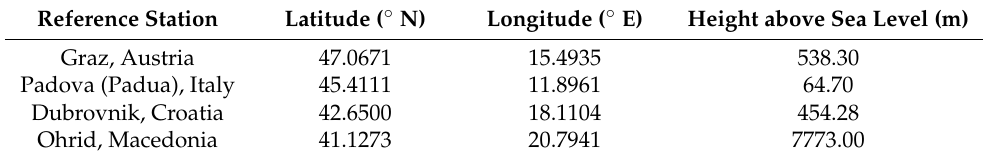
Figure 1. Positions of Eyjafjallajökull volcano ( left ), and the IGS reference stations in the Adriatic Sea region that provided GPS observations for the research presented ( right ); illustrations were arranged using Open Street Map spatial data, and a bespoke software development in the R environment was used for statistical learning. Table 1. Details of the IGS reference stations that provided GPS observations used in this research. Reference